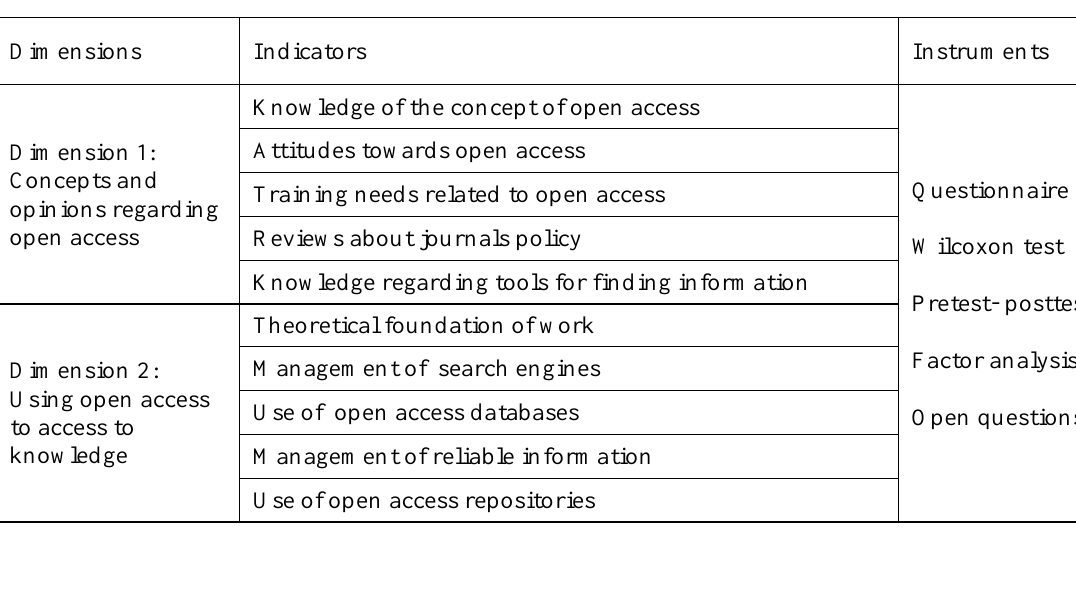
Research Dimensions, Indicators, and